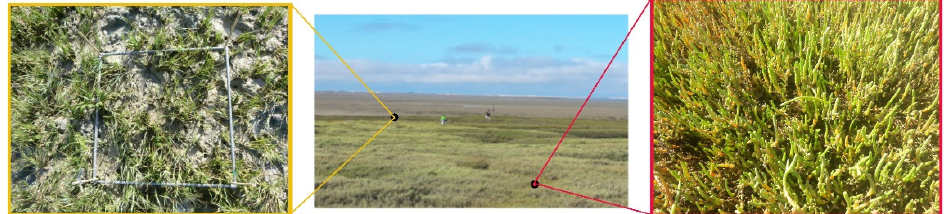
Figure 2. Westward view of the study area from the uppermost part of the salt marsh. The zoomed pictures show a detail of Sporobolus maritimus —predominant vegetation of the low marsh—( left ) and Sarcocornia spp.—predominant vegetation of the medium marsh—( right ).